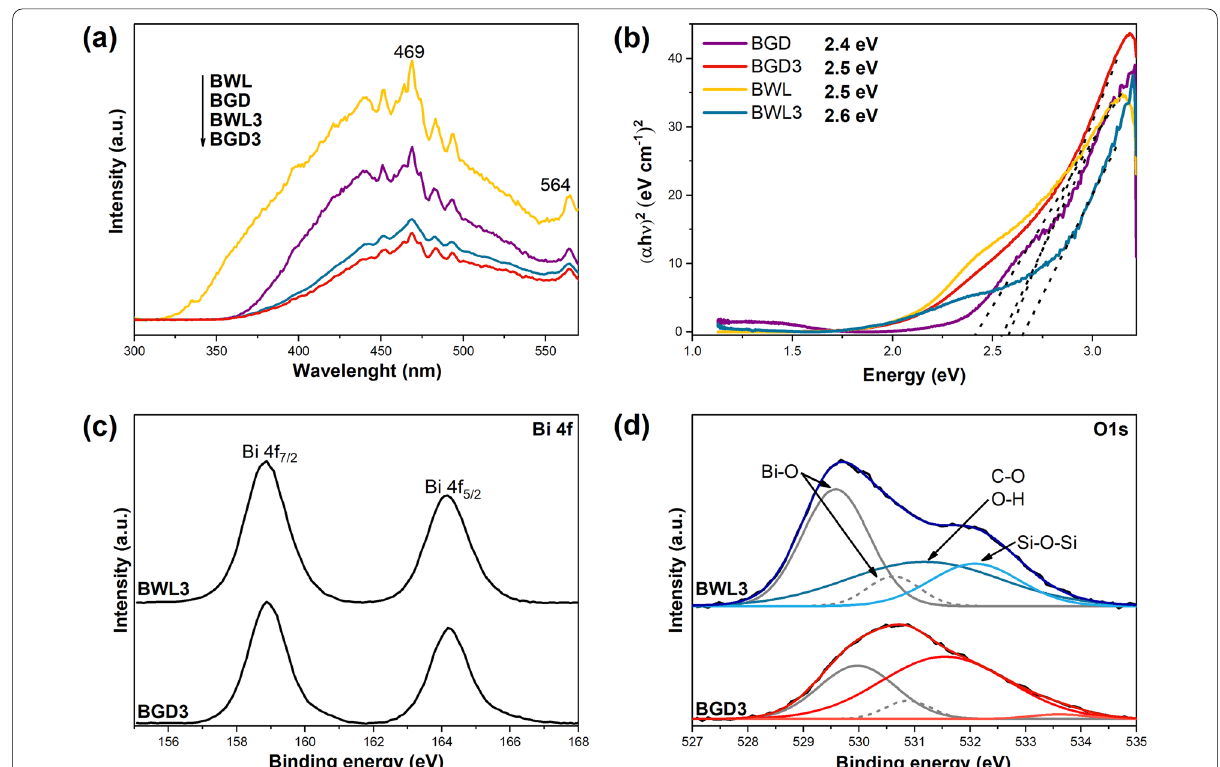
Fig. 4 Photoluminescence spectra, Tauc plots for the bandgaps calculation, Bi4f and O1s XPS spectra of